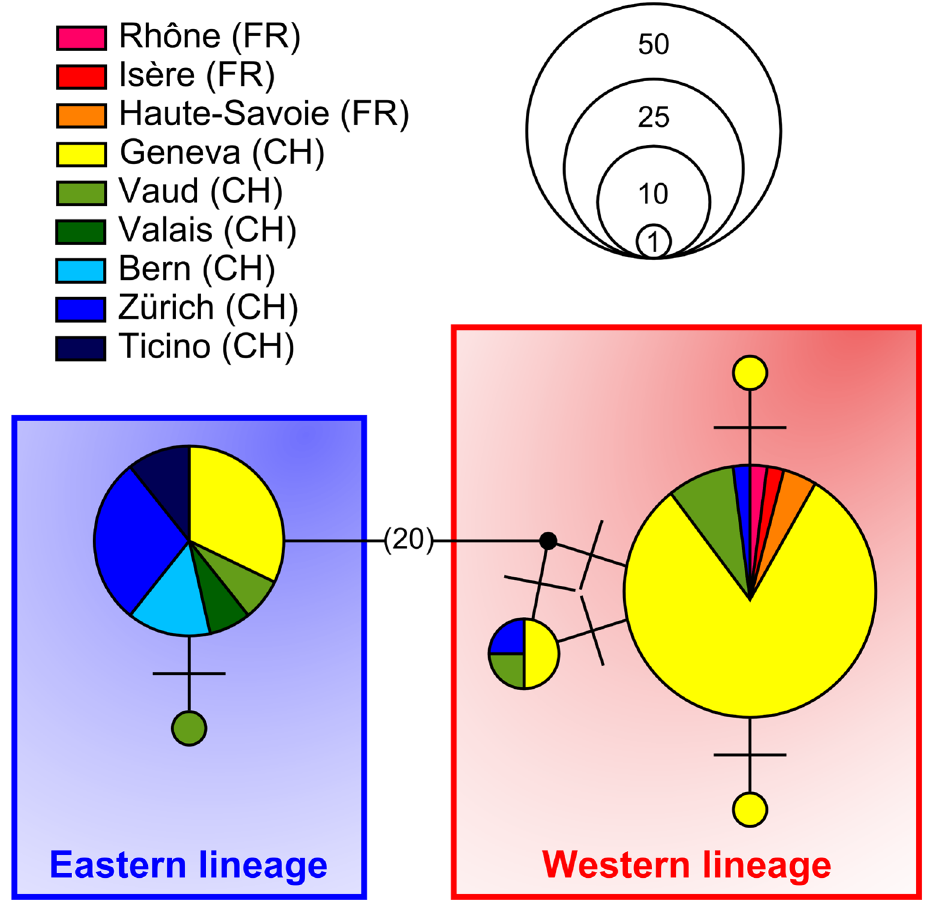
Fig 4. Median-joining network of COI haplotypes (384 bp) from Switzerland and neighbouring France. This network is restricted to 84 P . kuhlii that were sampled within a radius of 40 km, i.e. within flying distance for these bats. Each variant is represented as a circle, the area of which is proportional to the number of individuals sharing this haplotype. Transversal bars indicate one mutation between haplotypes and black dots symbolize the reconstructed missing haplotypes. Red and blue frames correspond to the Western and Eastern lineages, respectively.